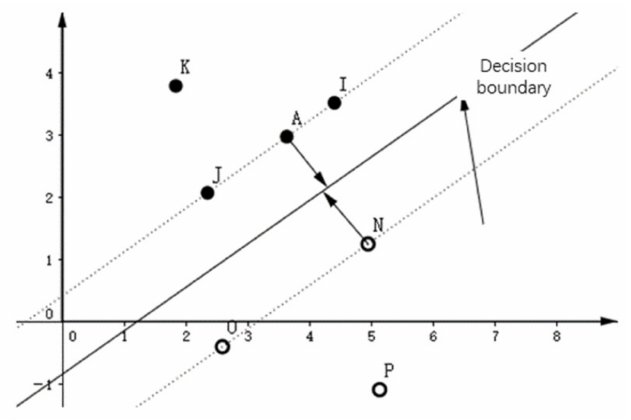
Figure 2. Schematic diagram of support vector